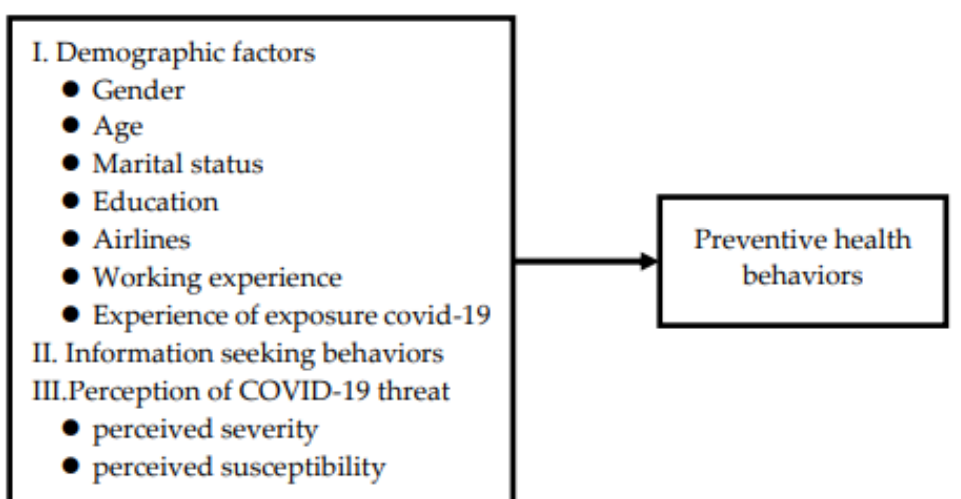
Figure 1. Research framework showing factors potentially associated with preventive health behavior related to COVID-19.